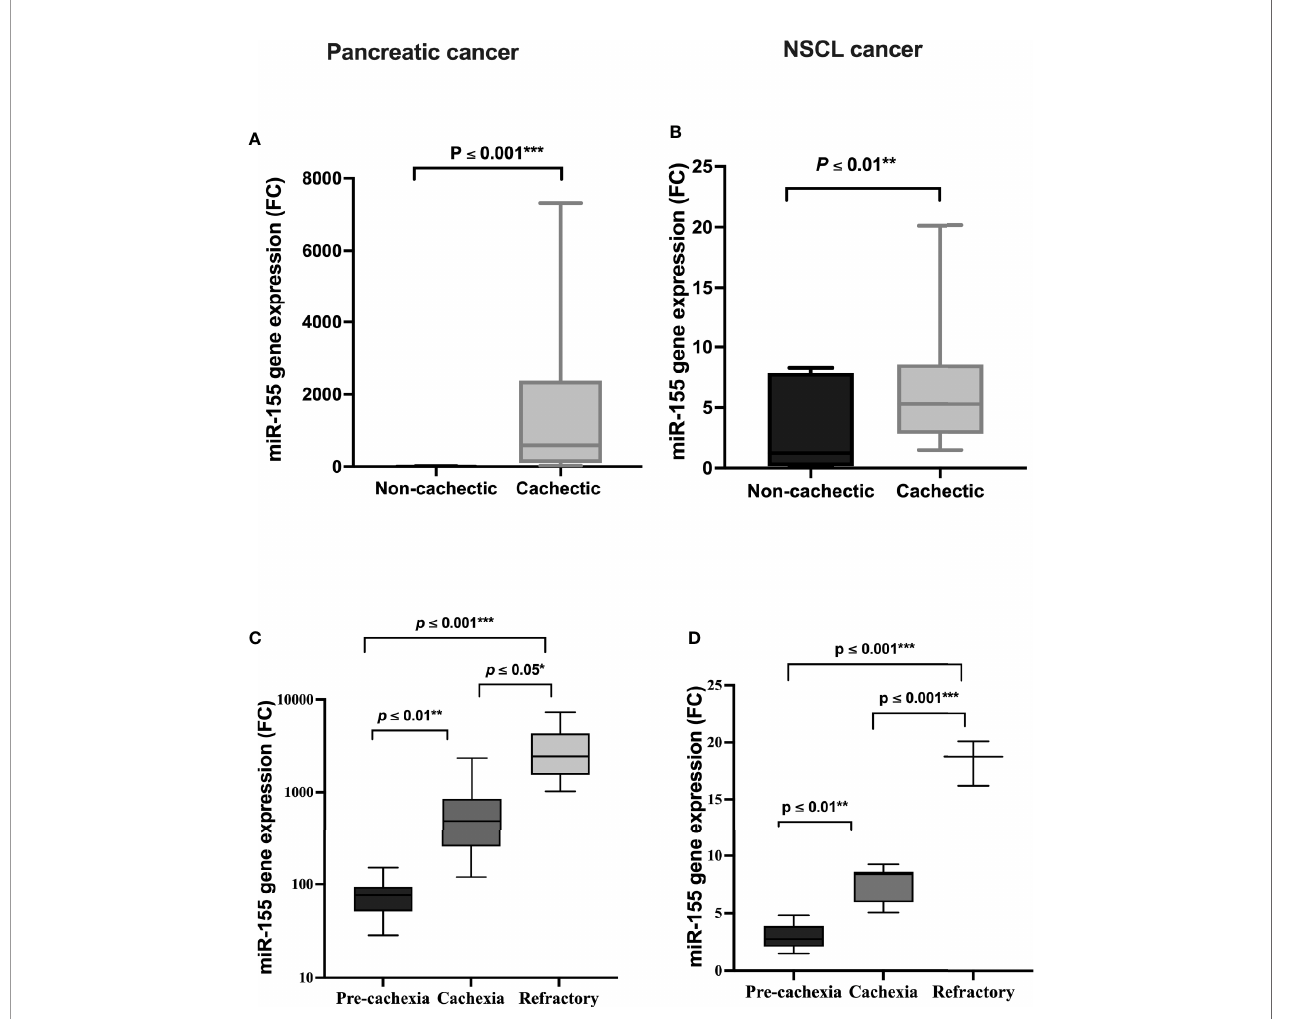
FIGURE 3 | Serum expression of miR-155 in (A) pancreatic and (B) NSCL non-cachectic and cachectic cancer patients and its expression in different grades of cachexia severity in (C) pancreatic and (D) NSCL cancer patients. Comparison between cachectic and non-cachectic groups was performed by chi-square test at *p < 0.05. **Signi fi cant difference at p ≤ 0.01 and *** at p ≤ 0.001. Comparison between all cachexia grades was performed by ANOVA test followed by Bonferroni ’ s post-hoc test; at *p < 0.05. **Signi fi cant difference at p ≤ 0.01 and *** at p ≤ 0.001. NSCL, non-small cell